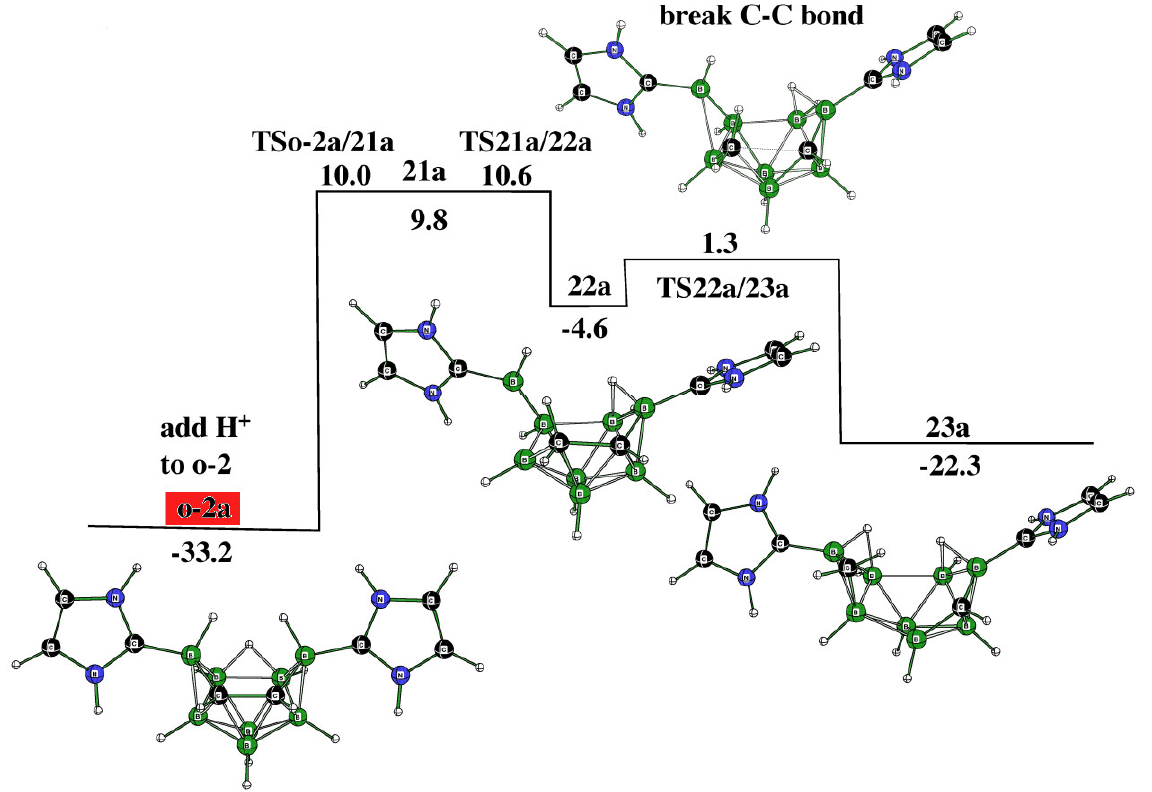
Figure 9. Relative free energies (kcal.mol − 1 ) of the individual stationary points on the potential energy surface (PES) of the formation of the cation, 23a , through another cation, 22a (see Tables 1 and S1 and Section 3 for details).